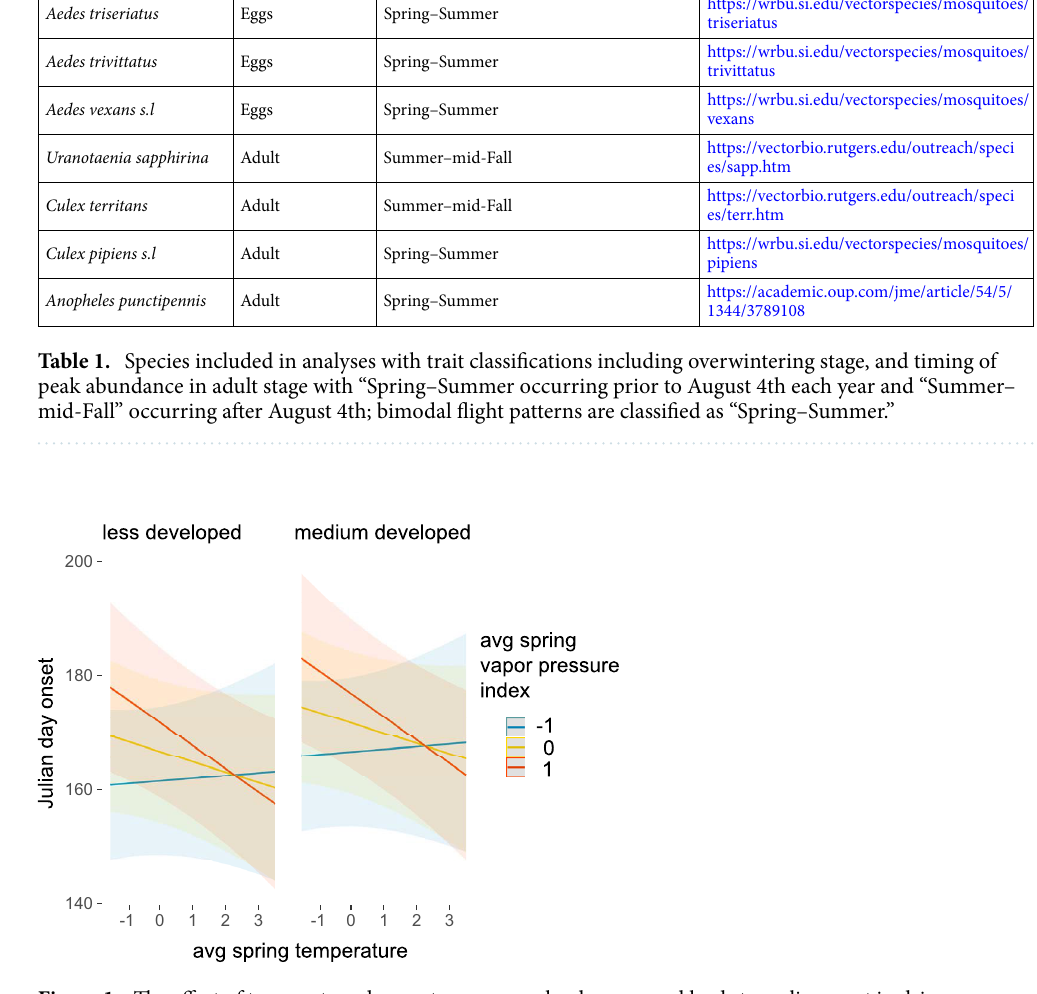
Figure 1. The effect of temperature does not vary across landscapes, and leads to earlier onset in drier conditions (e.g., higher spring vapor pressure deficit) but has minimal impact on phenology in wetter conditions. These plots also demonstrate a weak effect of later onset in medium developed landscapes. Plots were generated using the ‘plot_model’ function in the sjPlot package and functions in ggplot2 package in